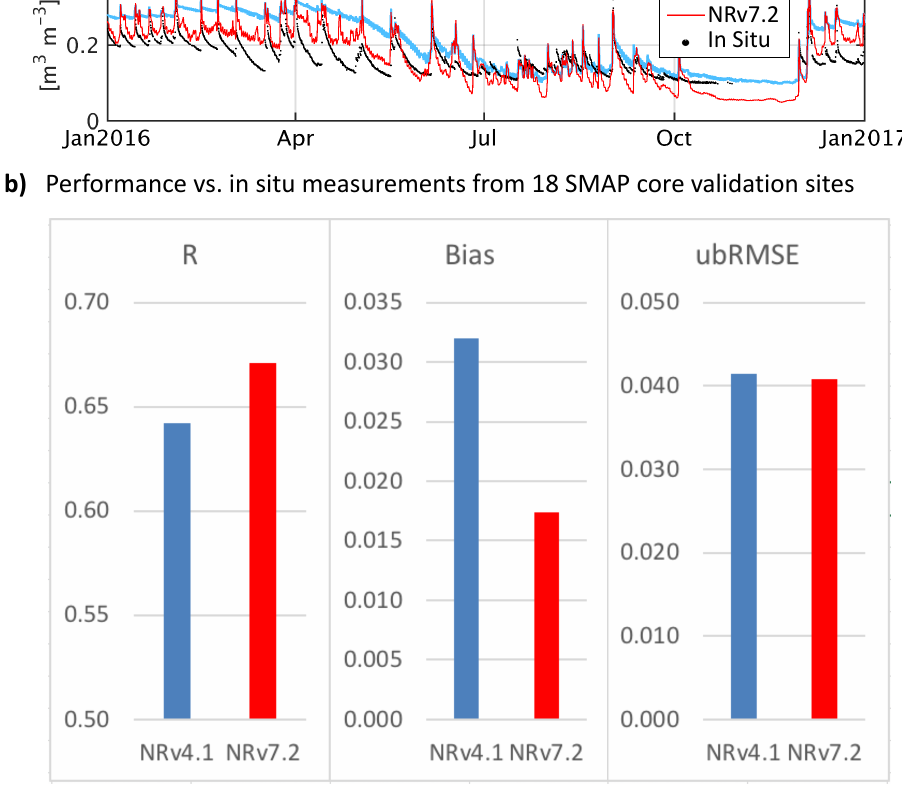
Figure 8. Surface soil moisture at Little Washita, OK, USA for two versions of the NASA Catchment model ( a ). Average surface soil moisture skill ( b ) in terms of time series correlation (R), bias, and unbiased root mean squared error (RMSE) (or standard-deviation of the error). Skill is measured vs. in situ measurements from 18 SMAP core validation sites [45] and then averaged across the sites. The improved model version (NRv7.2) uses updated land cover, topography, and vegetation parameters based on remote sensing observations and was further calibrated using SMAP soil moisture